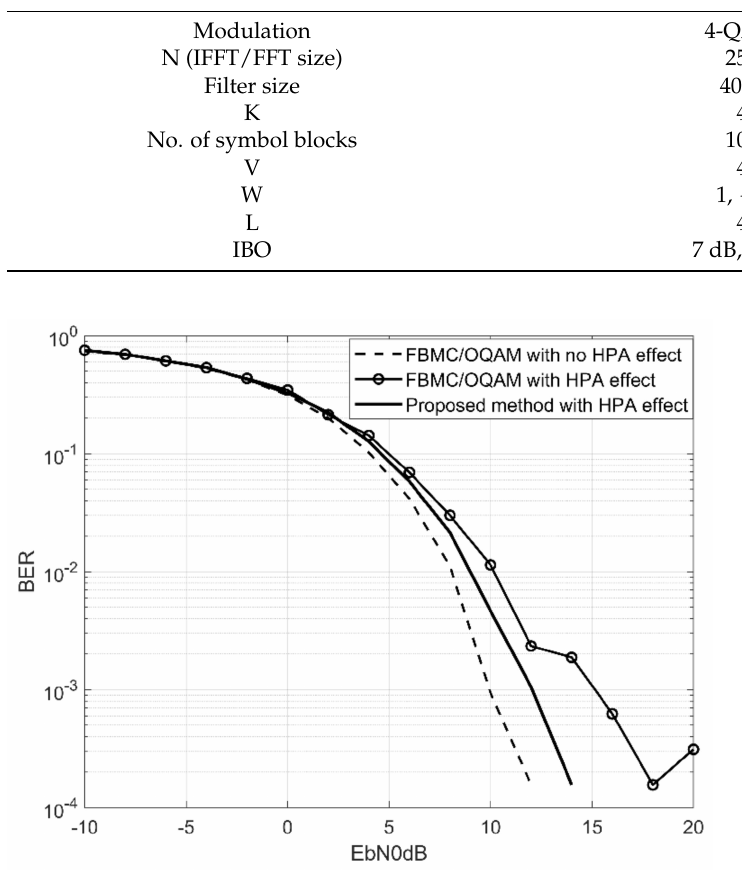
Figure 7. BER (bit-error-rate) comparison with HPA (high-power amplifier) effect for IBO = 7 dB (input back-off).